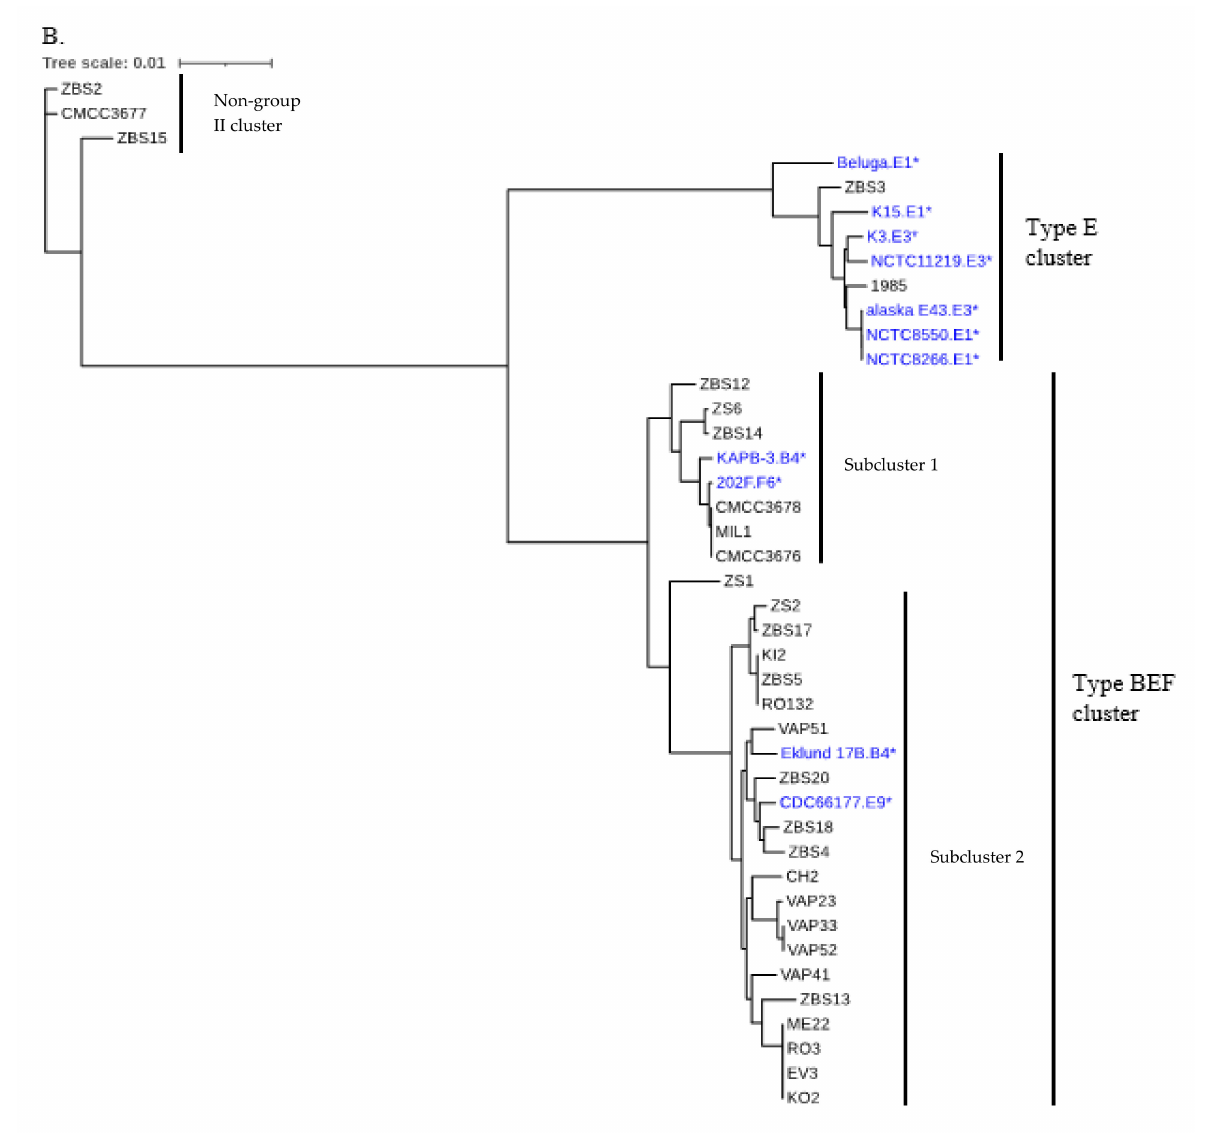
Figure 2. Phylogenetic trees of group II and non-group II nontoxic and toxic strains: ( A ) Analysis based on 12 housekeeping genes. ( B ) Analysis based on core genomes. Black, WGS determined in this work; Blue, WGS from NCBI. Toxic strains: * Scale indicates the number of substitutions per nucleotide